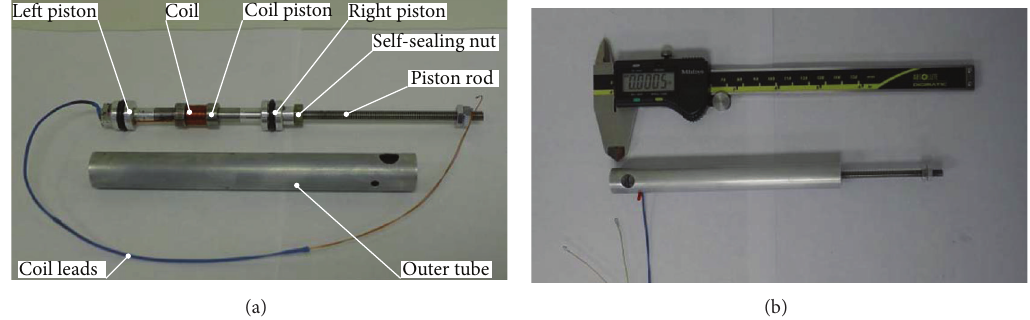
Figure 9: The fabricated prototype damper: (a) parts and (b)